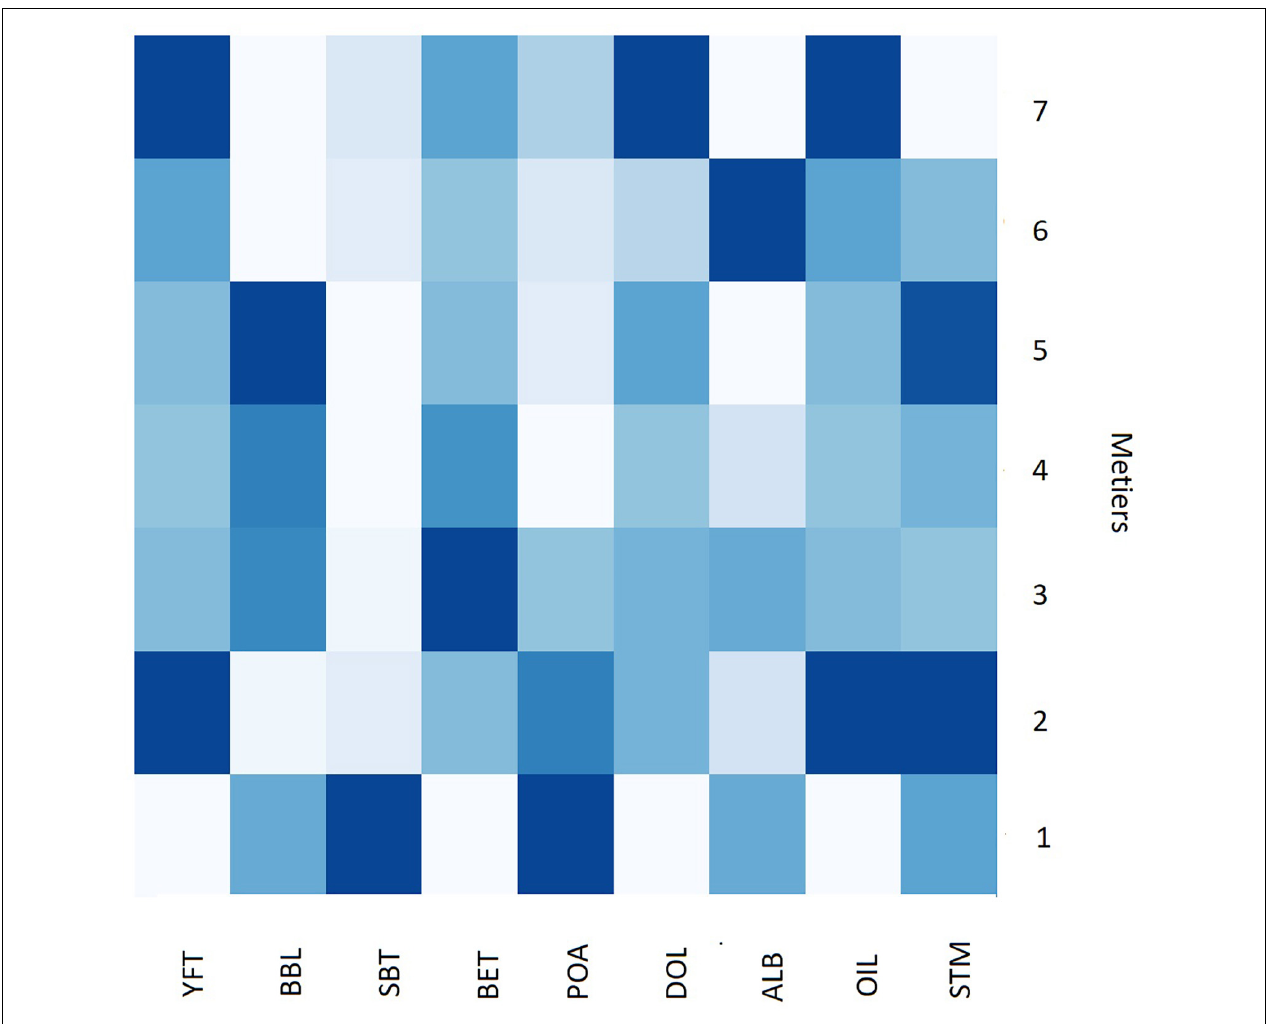
FIGURE 7 | Heat map dendrogram of the proportion of each catch variable [based on color density with dark (light) shading meaning high (low) relative value] within the seven métiers in the Eastern Tuna and Billfish Fishery (ETBF). See Table 1 for description of